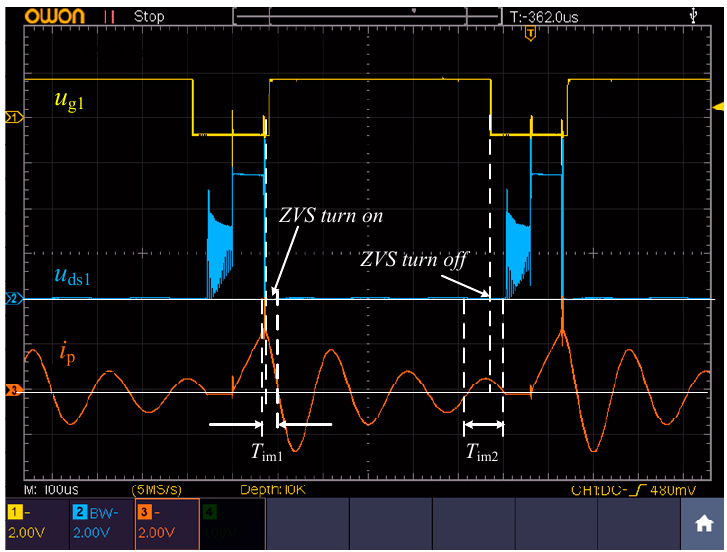
Figure 17. Experimental results of soft switching condition of IIEIFR converter.